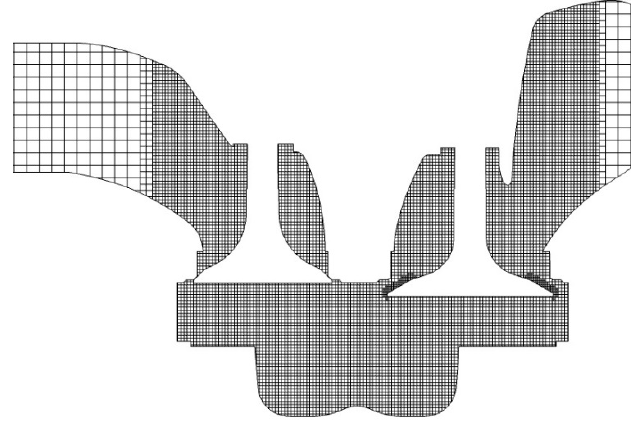
Figure 13. Schematic diagram of engine test